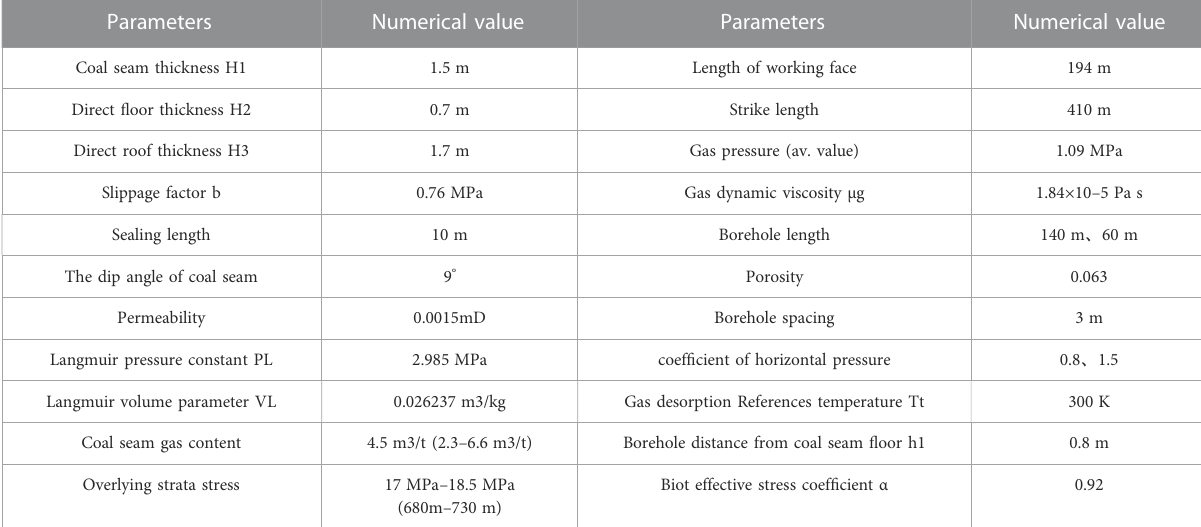
TABLE 2 Numerical simulation base parameters of the original extraction